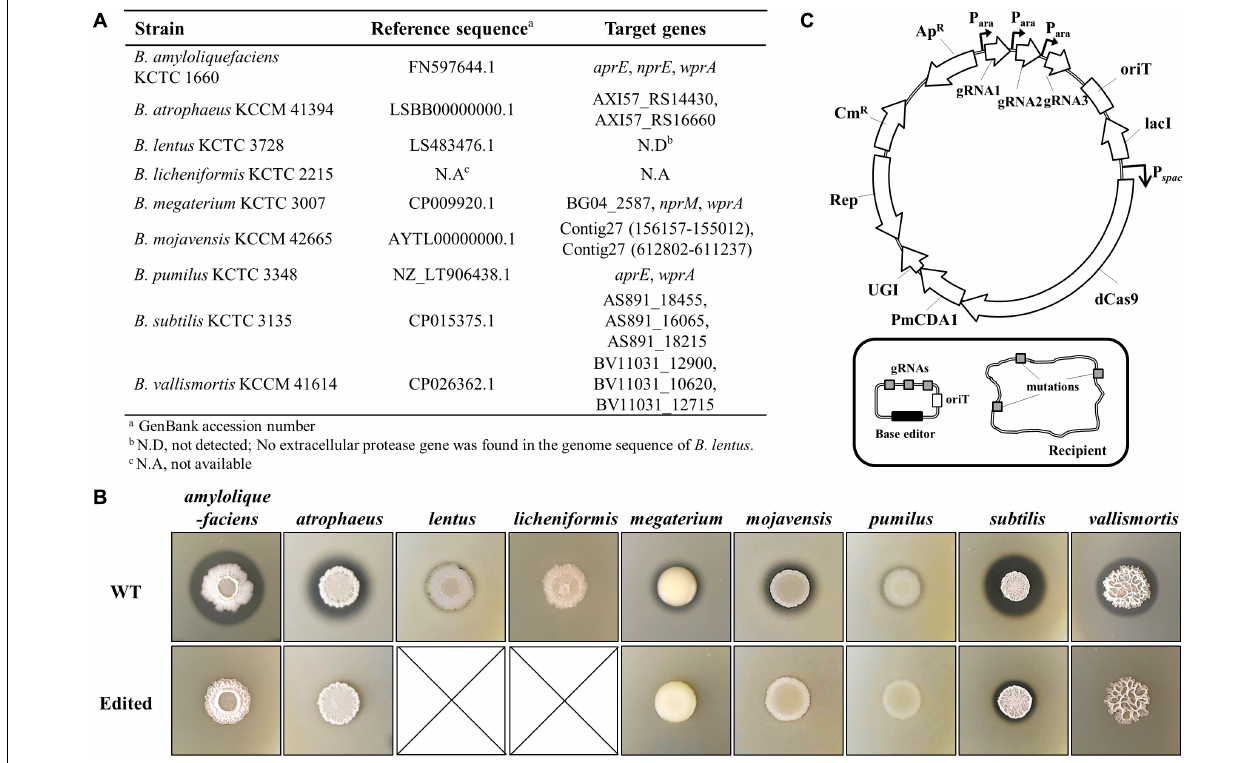
and recipient’s exclusion protein YddJ (Avello et al.,